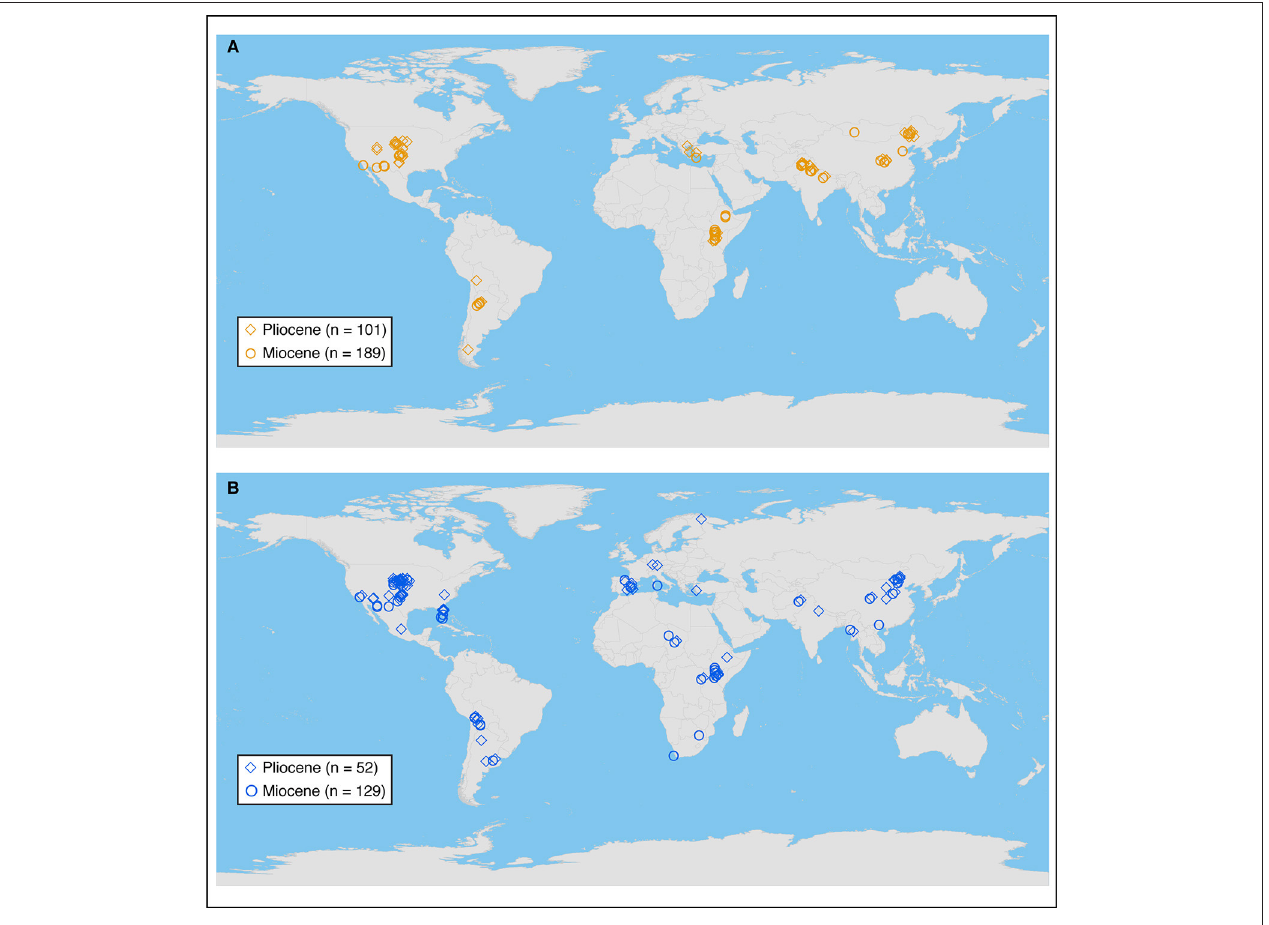
FIGURE 1 | Locations of sample localities for Miocene and Pliocene paleosol carbonates (A) and biominerals (B)